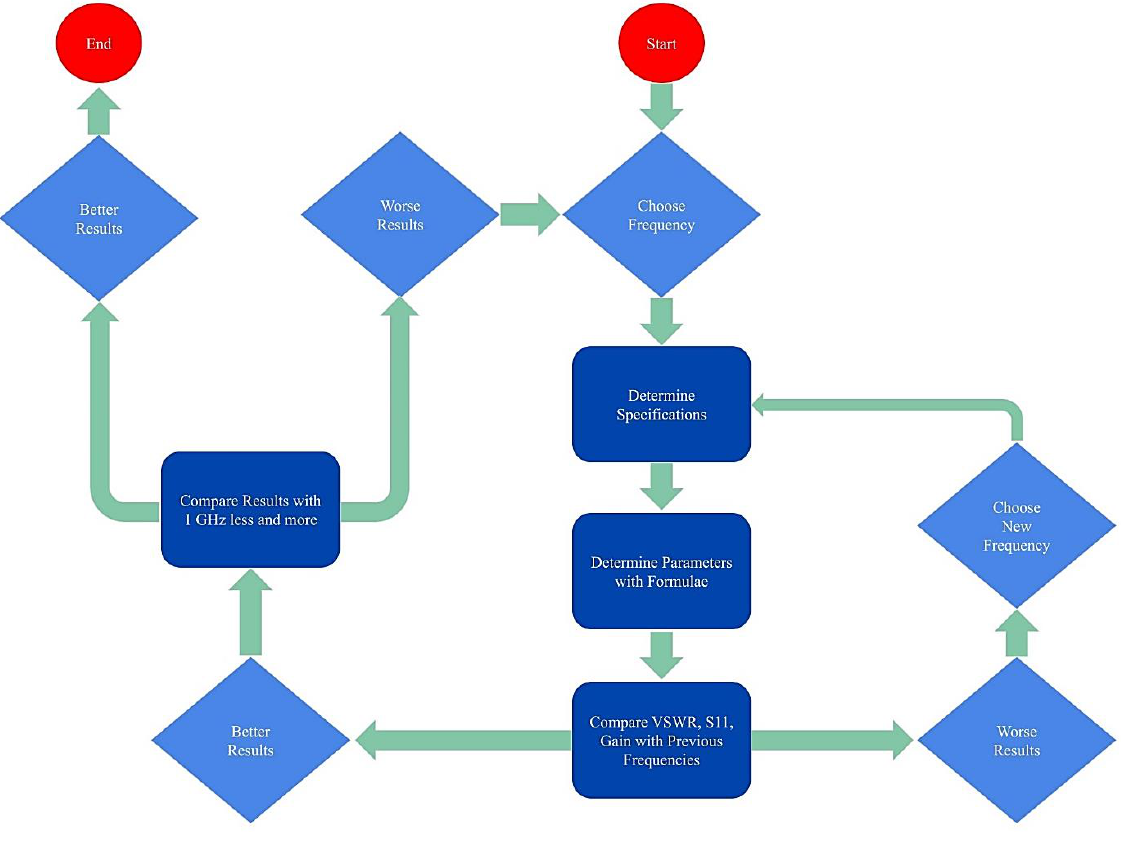
Figure 4. Flowchart of Design